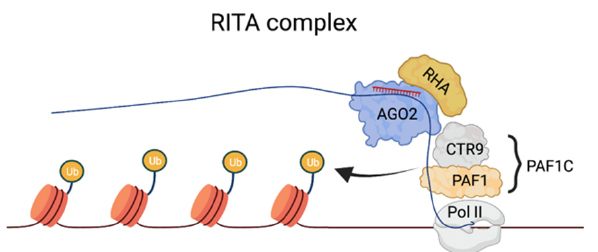
Figure 3. The RITA complex and the mechanisms of TGA at the p21 promoter. Binding sites on a nascent transcript overlapping the target are recognized by the saRNA–AGO2 complex. saRNA–AGO2 serves as a docking platform for components of PAF1C, which stimulate transcription initiation and recruit histone-modifying factors, such as E2/E3 ubiquitin ligase, to the Pol II complex to mediate H2B ubiquitination.